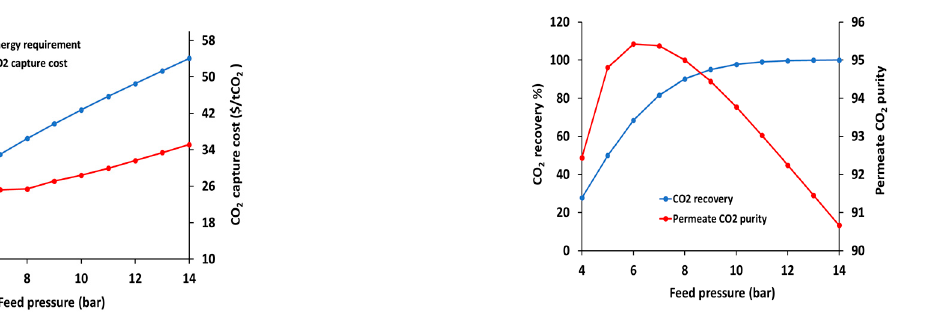
Figure 3. Effect of feed pressure on the membrane performance indicators ( left ) total energy require- ment ( right ) CO 2 recovery